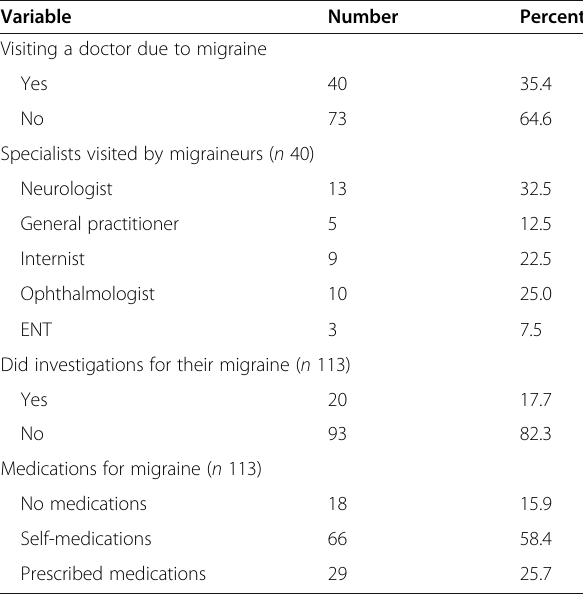
Table 3 Health care seeking practice of students when having migraine